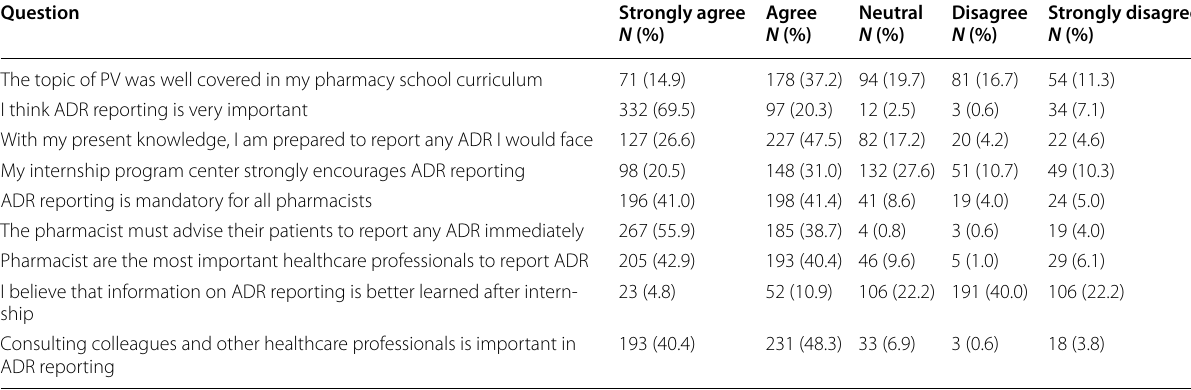
Table 6 Perception of participants toward pharmacovigilance and ADR reporting ( n